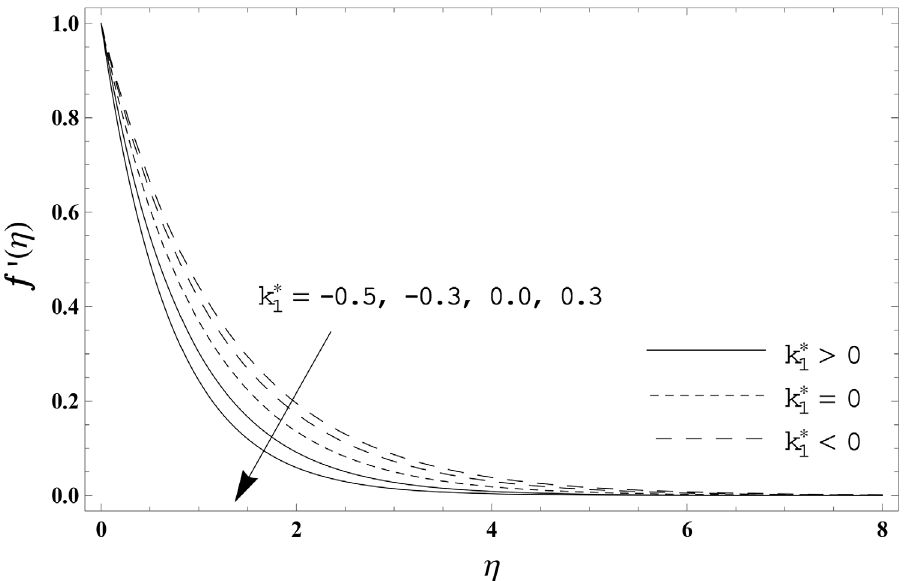
Fig 3. Effect of k (cid:3) 1 on f 0 ( η )